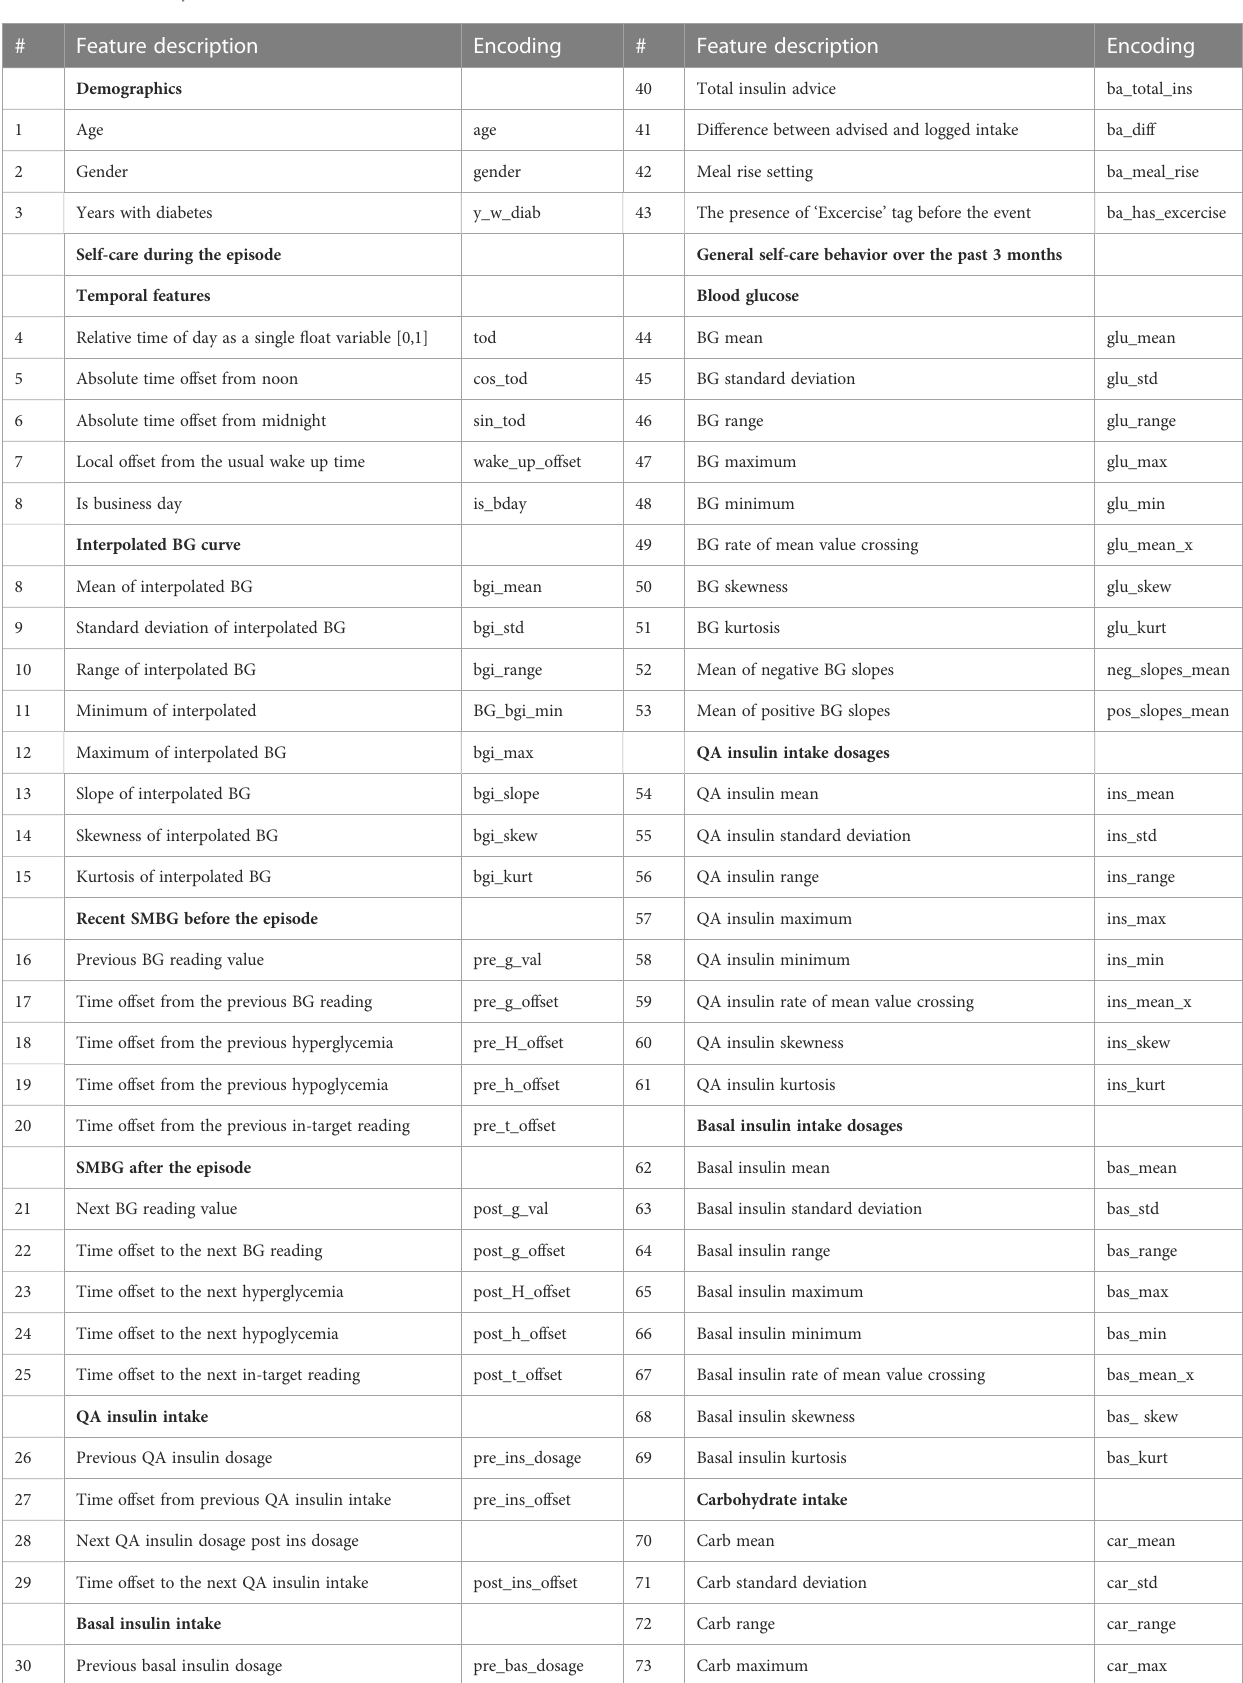
TABLE 1 Considered predictor